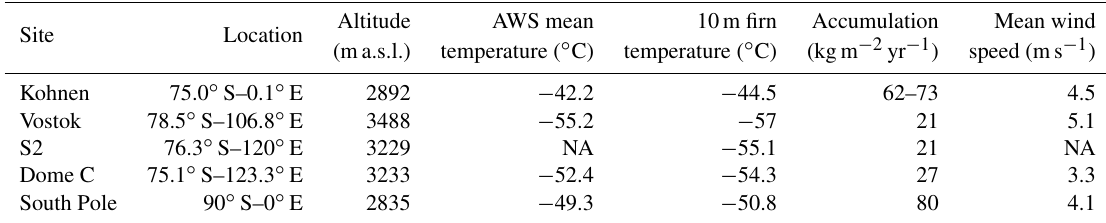
Table 1. Climatic conditions at the different study sites (Alley, 1980; Petit et al., 1982; Wendler and Kodama, 1984; Oerter et al., 2000; Ekaykin et al., 2002; van As et al., 2007; Lazzara et al., 2012; Casey et al., 2014; Genthon et al., 2015; Touzeau et al., 2016; Laepple et